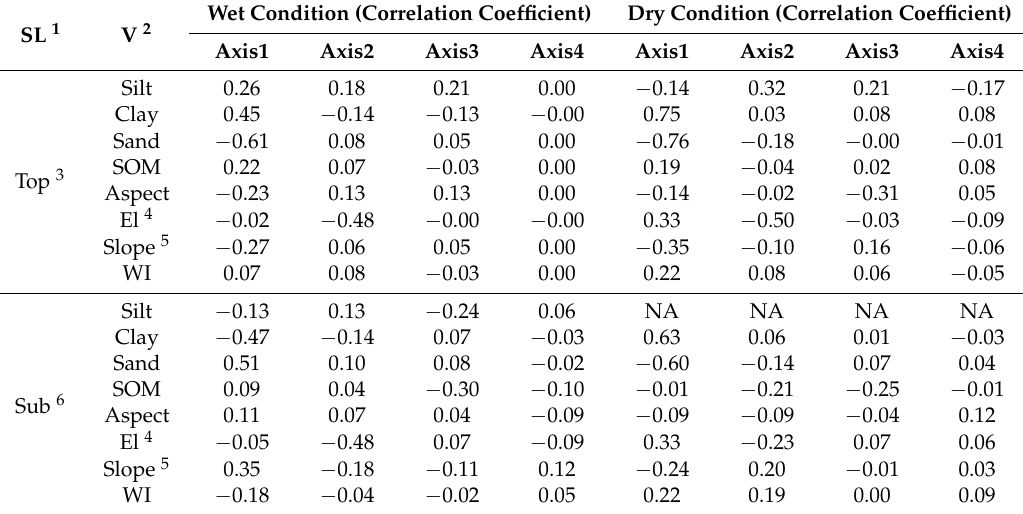
Table 5. Correlations between the explanatory variables and the ordination axes in the topsoil and subsoil layer.